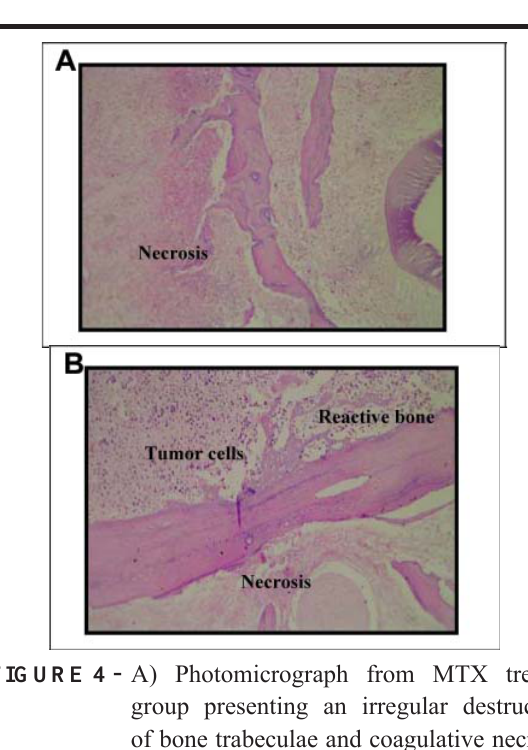
FIGURE 4 - A) Photomicrograph from MTX treated group presenting an irregular destruction of bone trabeculae and coagulative necrosis area. HE 100X. B) Osteoid production may be seen among tumor cells invading bone trabeculae. HE